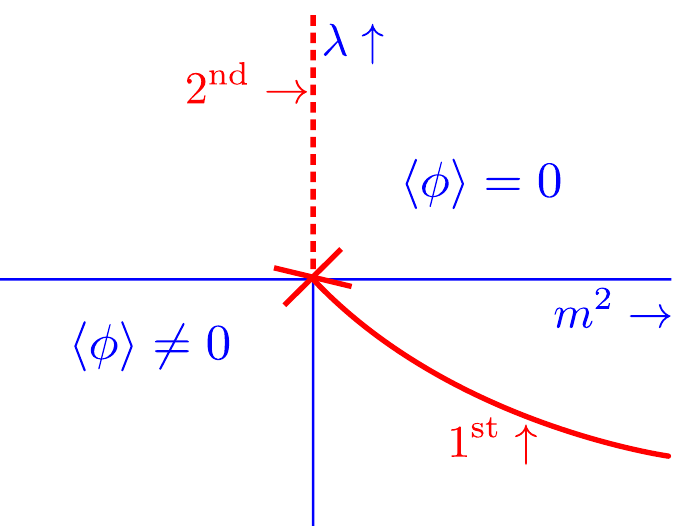
Figure 1. The standard diagram in mean field theory, with a tricritical point at the